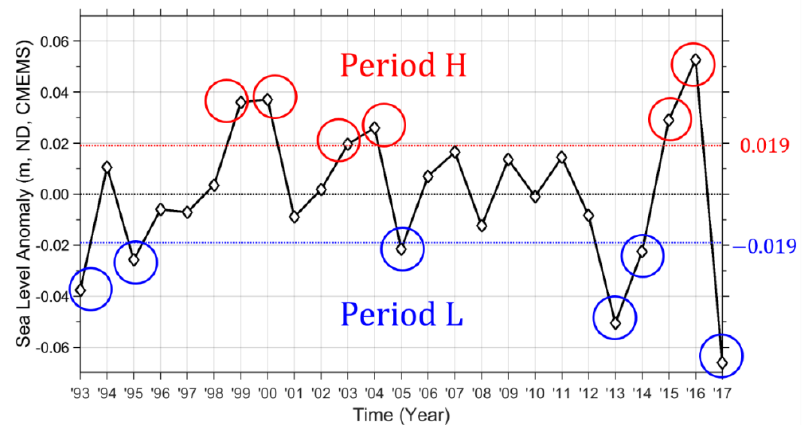
Figure 3. Time series of the detrended winter (ND) mean sea-level anomalies averaged over the NEAMS from 1993 to 2017, in which six years of high (above +0.019 m) or low (below −0.019 m) winter sea level anomalies are indicated as Period H (1999, 2000, 2003, 2004, 2015, and 2016) or Period L (1993, 1995, 2005, 2013, 2014, and 2017) with red and blue circles,